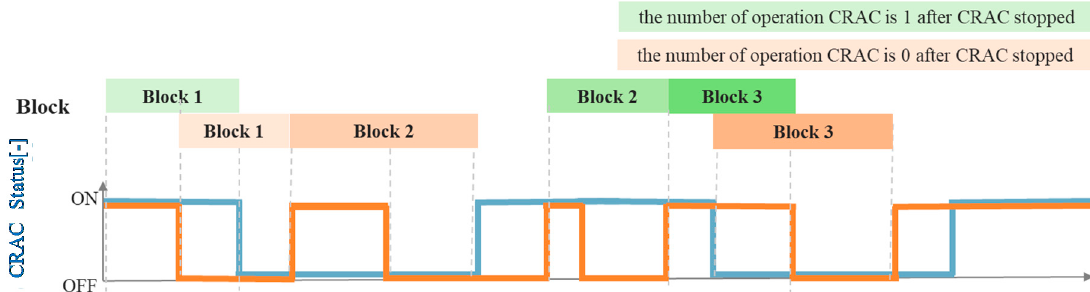
Figure 14. Image of blocks (case where both CRACs are operating).